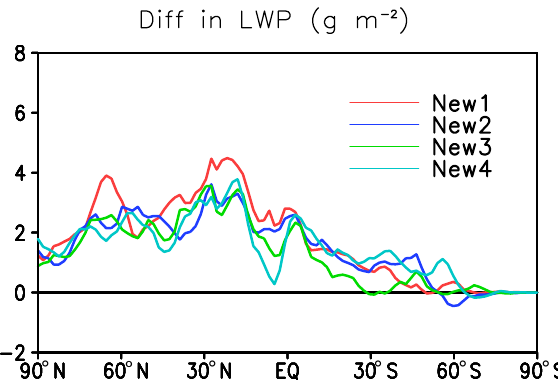
Figure 8. Annual, JJA, and DJF zonal mean differences in the liquid water path (LWP, gm − 2 ) between PD and PI derived from